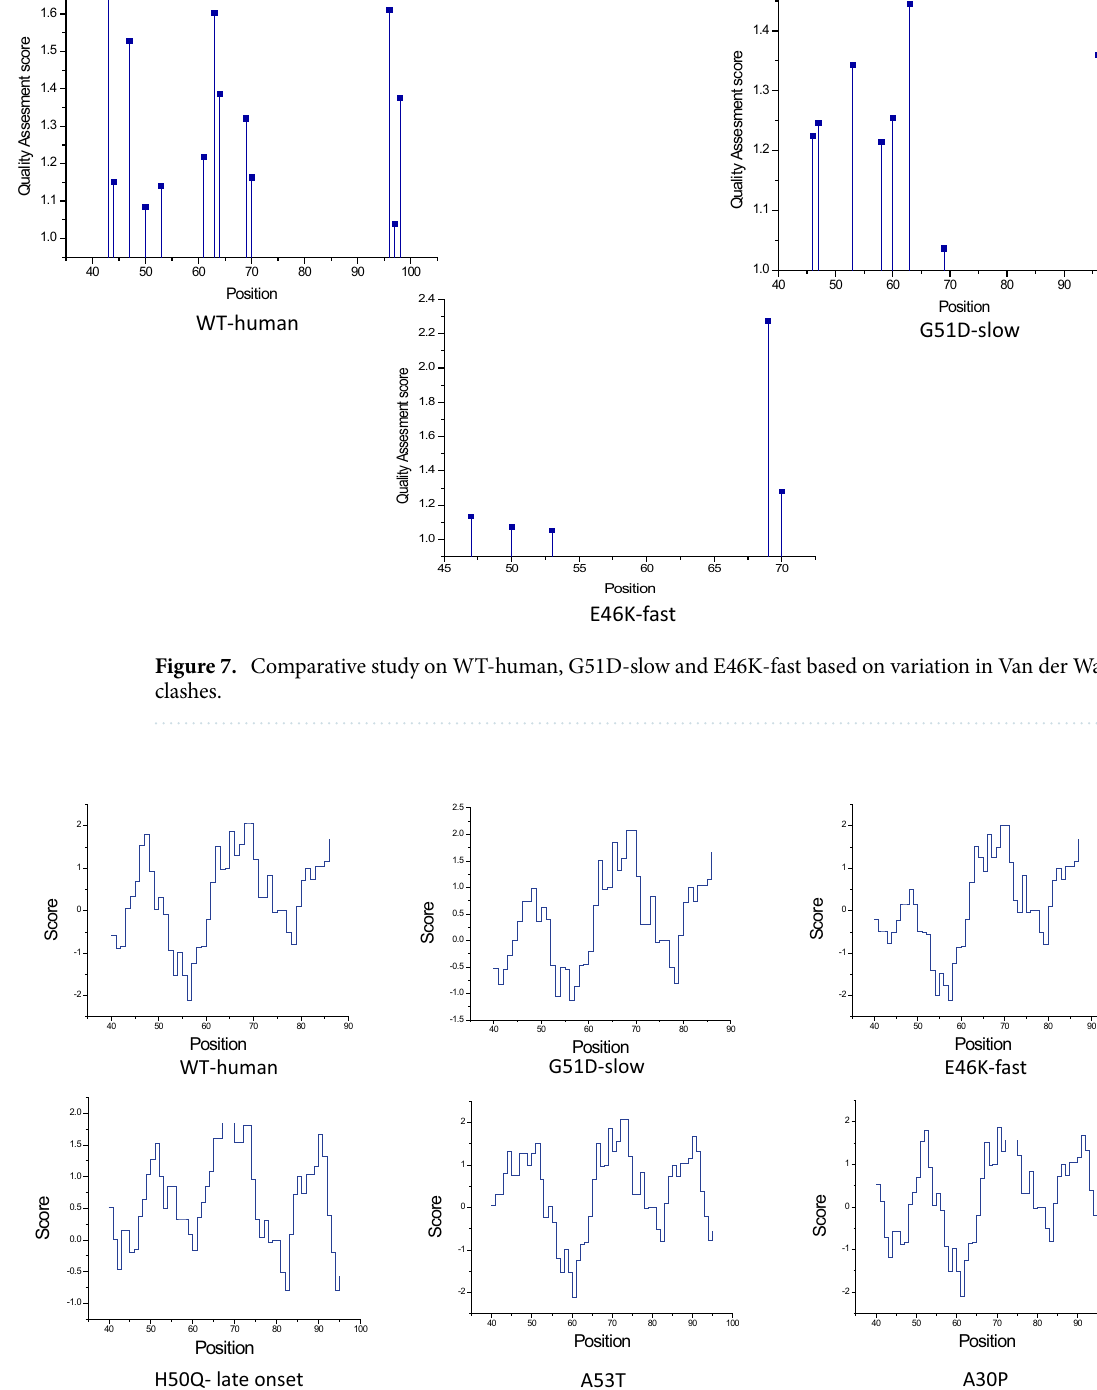
Figure 8. Comparative study on WT-human, G51D-slow, E46K-fast, H50Q, A53T and A30P based on hydropathic Index from 40 to 95 residual